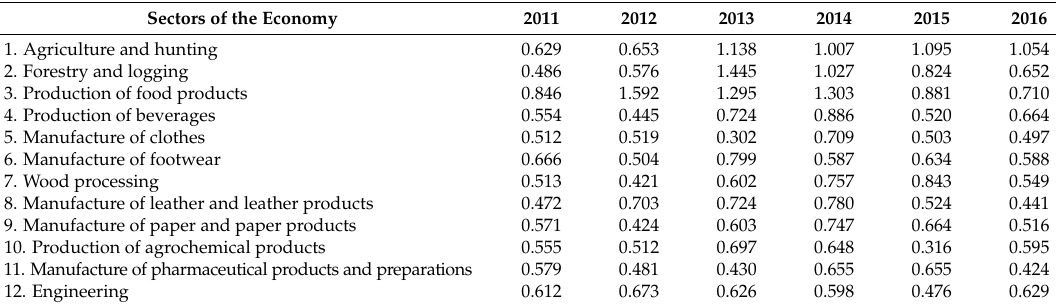
Table 1. The level of adaptability of sectors of the Ukrainian economy to the rise of prices for energy carriers (2011–2016), shares of